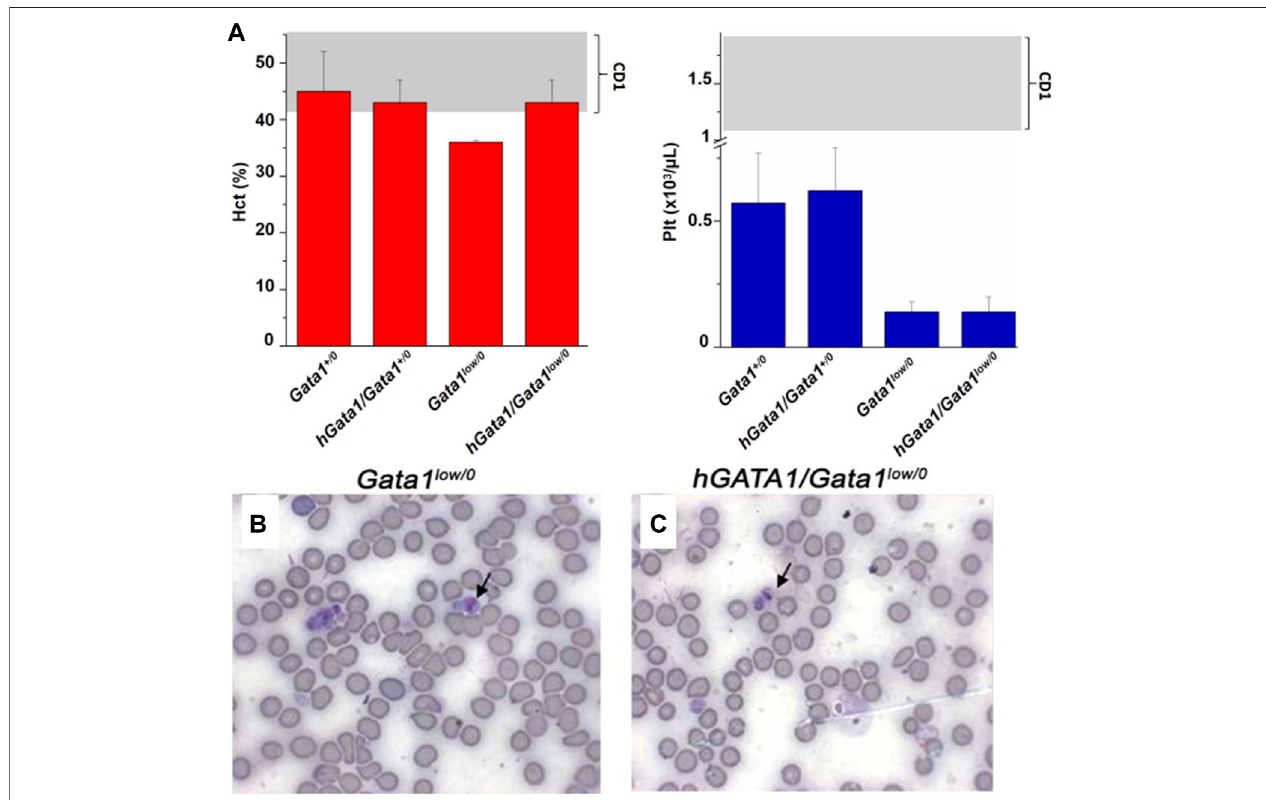
FIGURE 2 | The hGATA1 transgene rescues the hematocrit (Hct) but not the platelet counts of GATA1 low/0 mice. (A) Hct and platelet counts of4 months-old wild- type ( Gata1 +/0 )miceand Gata1 low/0 micecarryingornotthe hGATA1 transgene, asindicated.Thepresenceofthe hGATA1 transgenerestorestheHct of Gata1 low mice to normal values but does not alter their platelet counts, which remain lower than normal. The shaded areas indicate the range of Hct and Ptl observed in CD1 males available from commercial sources (https://www.criver.com/sites/default/ fi les/resources/CD1IGSMouseModelInformationSheet.pdf). Results are expressed as Mean( ± SD)ofthoseobseved with5miceperexperimental group.StatisticalanalyseswasperformedbyOne-wayanalysisofvarianceTukeyMultipleComparisonTest. Results of the statistical analyses: Hct (cid:2) Gata1 +/0 vs Gata1 low/0 p < 0.05, other values are not statistically different; Ptl (cid:2) Gata1 +/0 vs. Gata1 low/0 p < 0.05, Gata1 +/0 vs. hGATA1/Gata1 low/0 p < 0.05, hGata1/Gata1 +/0 vs. Gata1 low/0 p < 0.05 and hGata/Gata1 +/0 vs. hGata1/Gata1 low/0 p < 0.05. (B,C) Representative blood smears of the blood from 4 months old Gata1 low/0 (B) and hGATA1/Gata1 low/0 (C) littermates showing the presence of megathrombocytes in